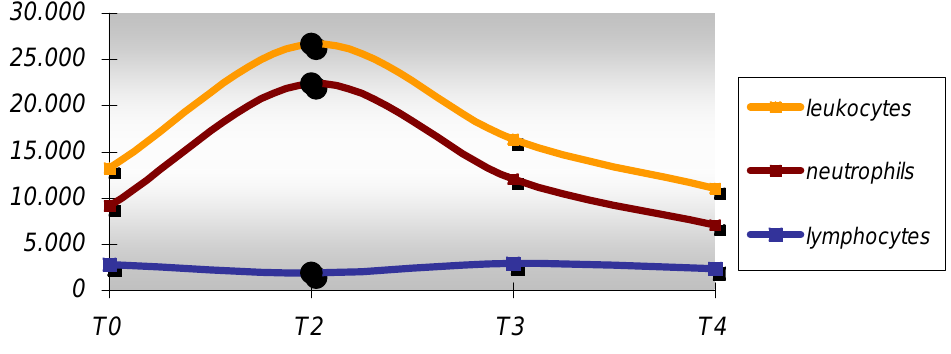
Figure 5: Profile of leukocytes, segmented neutrophils and lymphocytes in G1 (0.25 mg/kg) at the four moments studied (T0 = pre-envenomation; T2 = 6h after envenomation; T3 = 24h after envenomation; and T4 = 72h after envenomation). (cid:122) = p <0.05. Botucatu, São Paulo, Brazil,